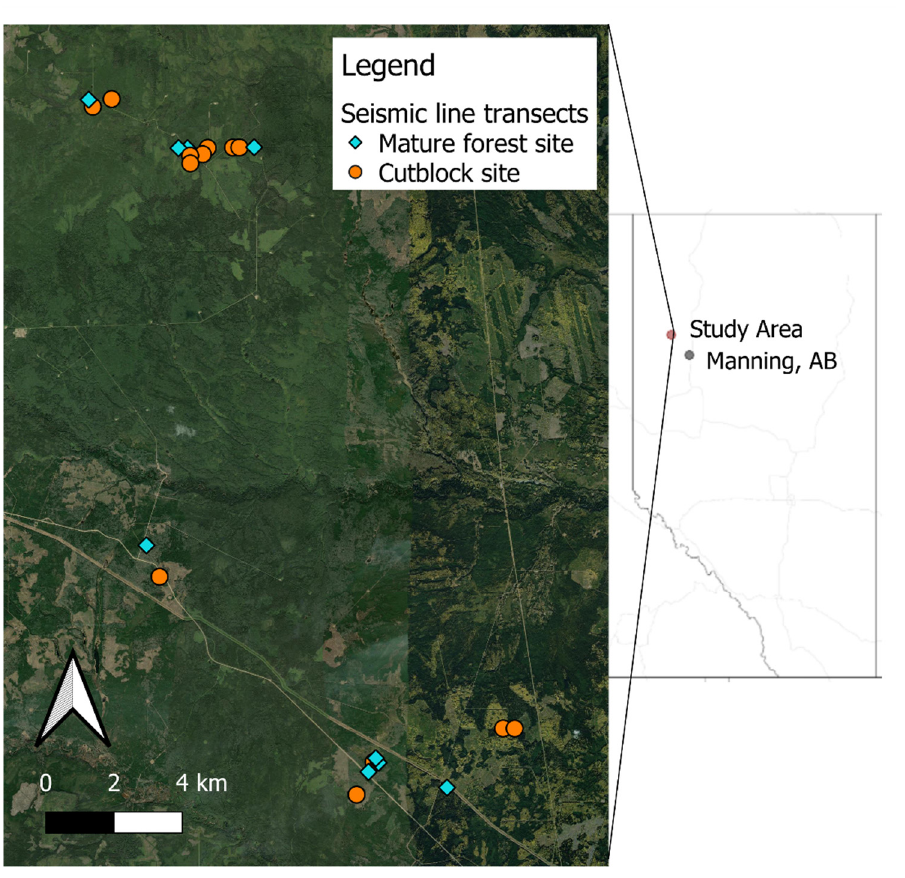
Figure 1. Study area in northwestern Alberta showing seismic line transect locations and their forest type; either mature forest (blue) or cutblock (orange). Image was created using QGIS version 3.16.0 [16].